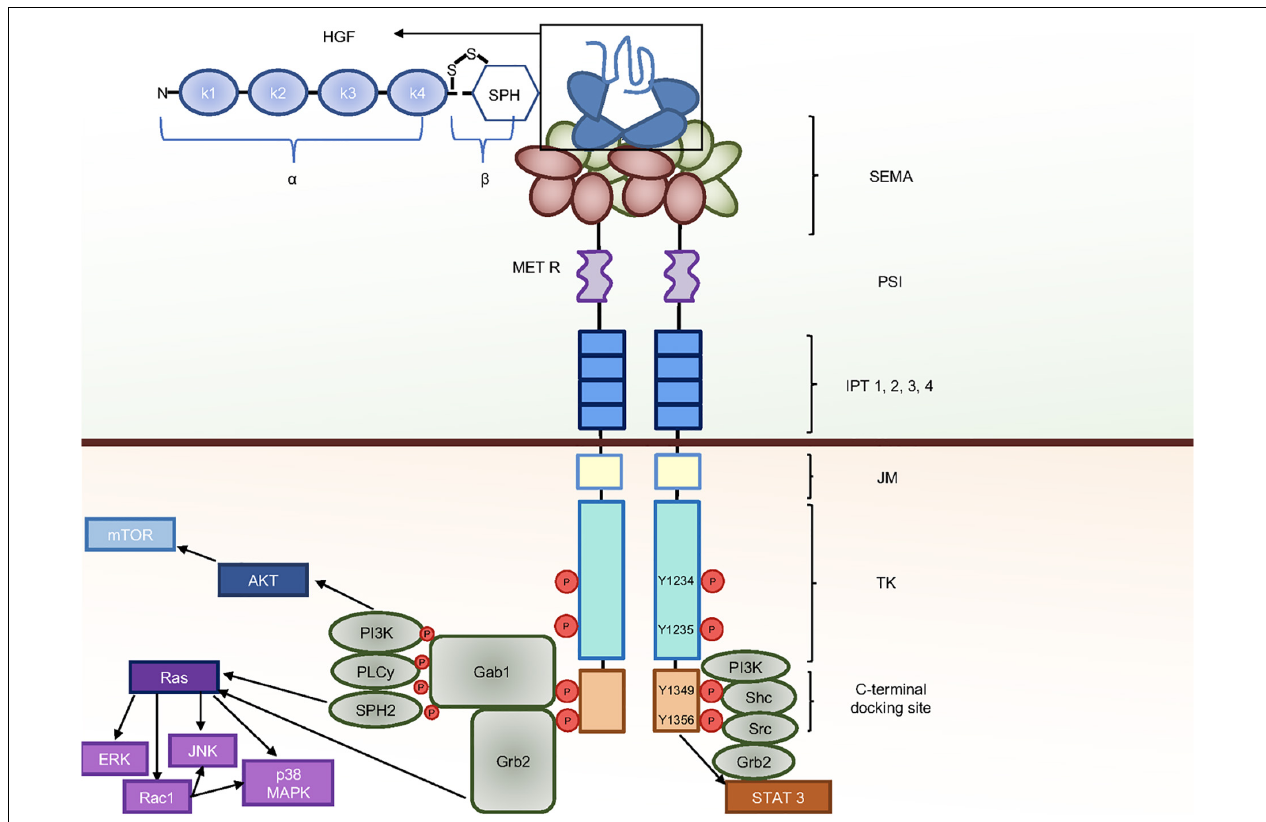
FIGURE 1 | HGF-MET and molecular signaling components. Upon HGF binding, MET forms dimers and transphosphorylates on the two catalytic tyrosines Y1234 and Y1235 and the two carboxyterminal tyrosines Y1349 and Y1356, which provide a docking platform for the binding of adaptor and effector signaling proteins. Different downstream pathways are then activated, leading to a variety of biological